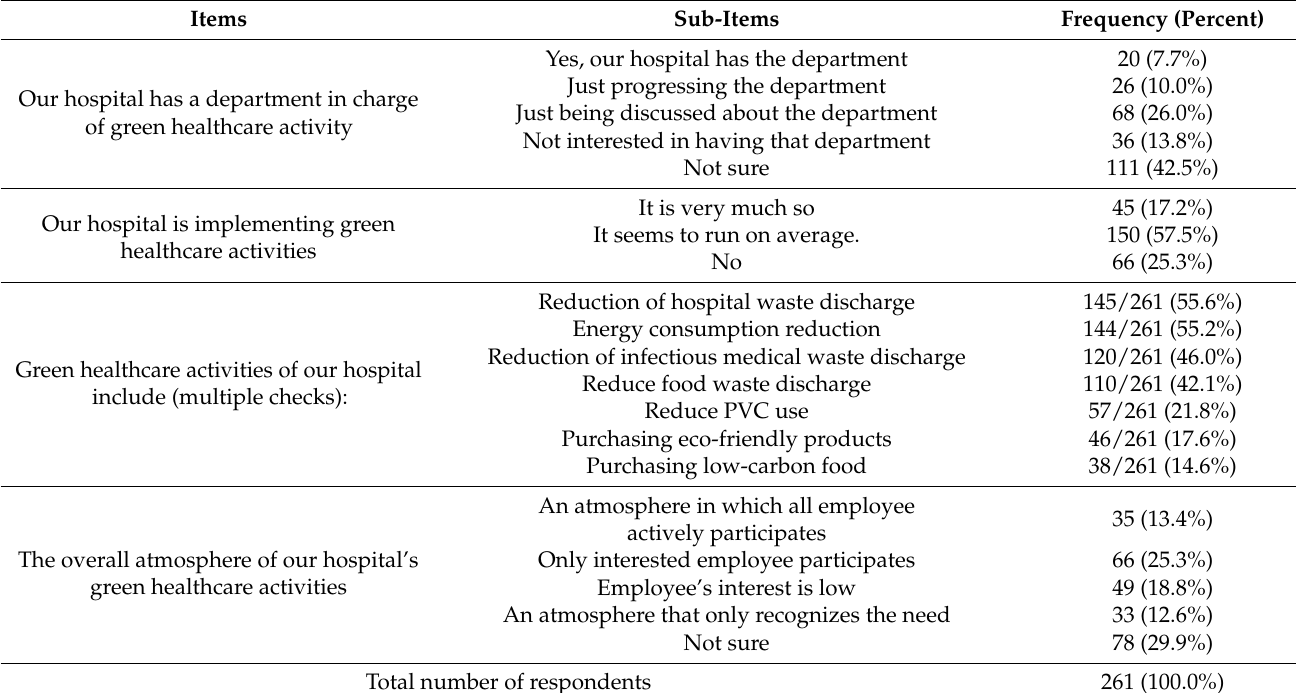
Table 4. Green healthcare activities of korean